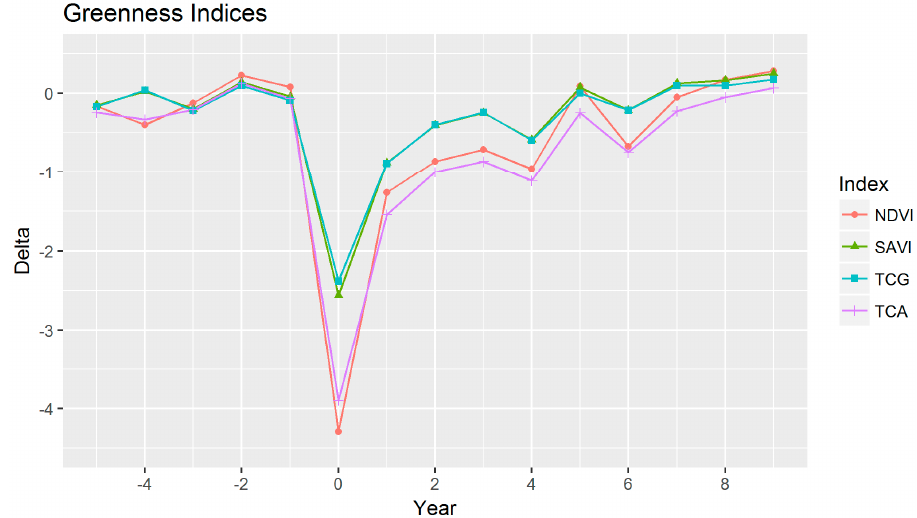
Figure 5. Mean values for greenness indices from five years prior to fire to nine years post-fire.